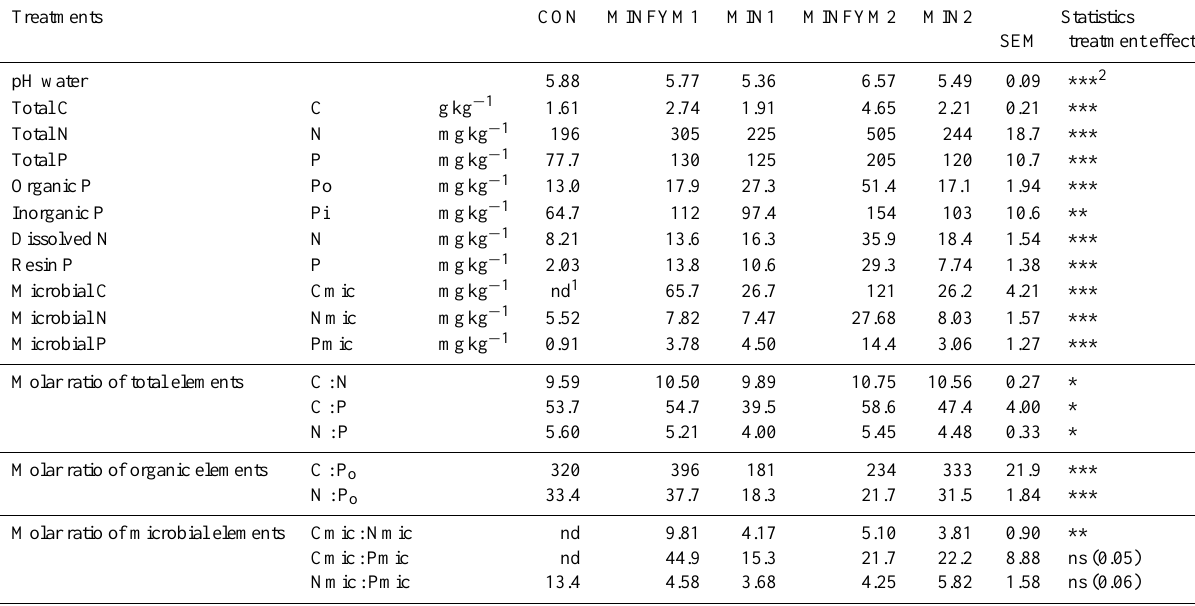
Table 3. Effects of different treatments on selected soil properties for the 0–10cm horizon and on soil C:N:P molar ratios at Saria, Burkina Faso. Soil pH, total C, and total N were reported in Kiba (2012) for soils sampled in 2009; the other analyses were done on soils sampled in 2013.